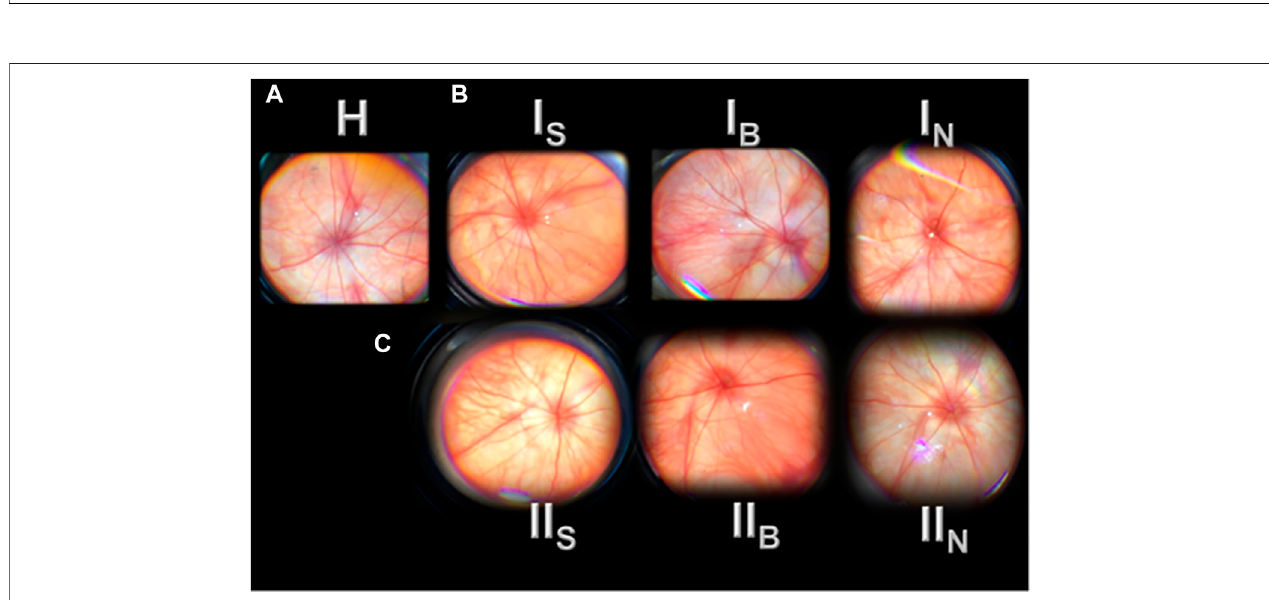
FIGURE 2 | Presentation of the rat retina before (H) and after retrobulbar administered agents (saline (S), BPC 157 (B), and L-NAME (N)), immediately (I), and at 20 min (II) (IS, IB, IN; IIS, IIB, and IIN). H, before agent ’ s application (H — healthy). Normal eye background, normal presentation of the retinal and choroidal blood vessels (A) . I, immediately after agent ’ s application (IS, IB, and IN) (B) . Normal eye background, normal presentation of the retinal and choroidal blood vessels (saline (IS), BPC 157(IB);moderategeneralizedirregularityindiameterofbloodvesselswithmoderateatrophyoftheopticdisk,faintpresentationofthechoroidalbloodvessels(IN). II,20 minafter agent ’ sapplication (IIS, IIB,andIIN) (C) .Normal eyebackground,normalpresentationoftheretinal andchoroidalblood vessels (saline(IIS), BPC157(IIB) (same presentation maintained till the end of the experiment, data not speci fi cally shown); moderate generalized irregularity diameter blood vessels with moderate atrophy of the optic disk, faint presentation of the choroidal blood vessels (IIN). The images are processed with software purchased with a USB microscope camera “ Veho Discovery VMS-004 Deluxe.